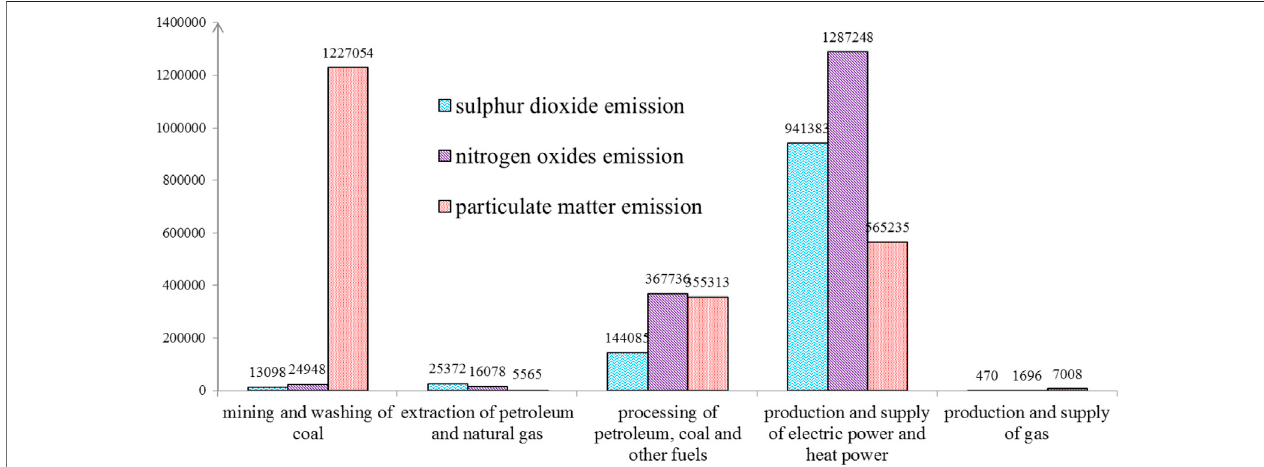
FIGURE 9 | Emission of industrial waste gas in industries surrounding energy in China, 2019 (ton). Source: The author searched the information from Emission of Industrial Waste gas by Sector in the China Statistical Yearbook on Environment 2020.